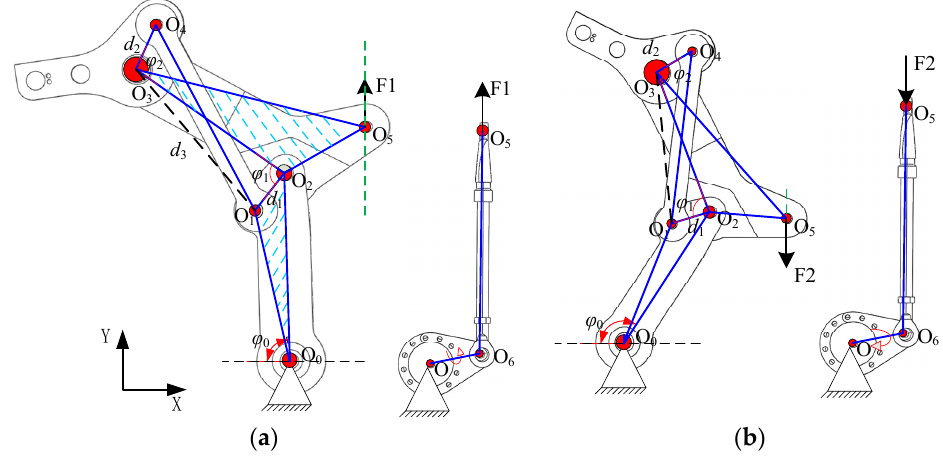
Figure 5. Mechanism diagram of the finger. (a) Grasping process. (b) Releasing process.